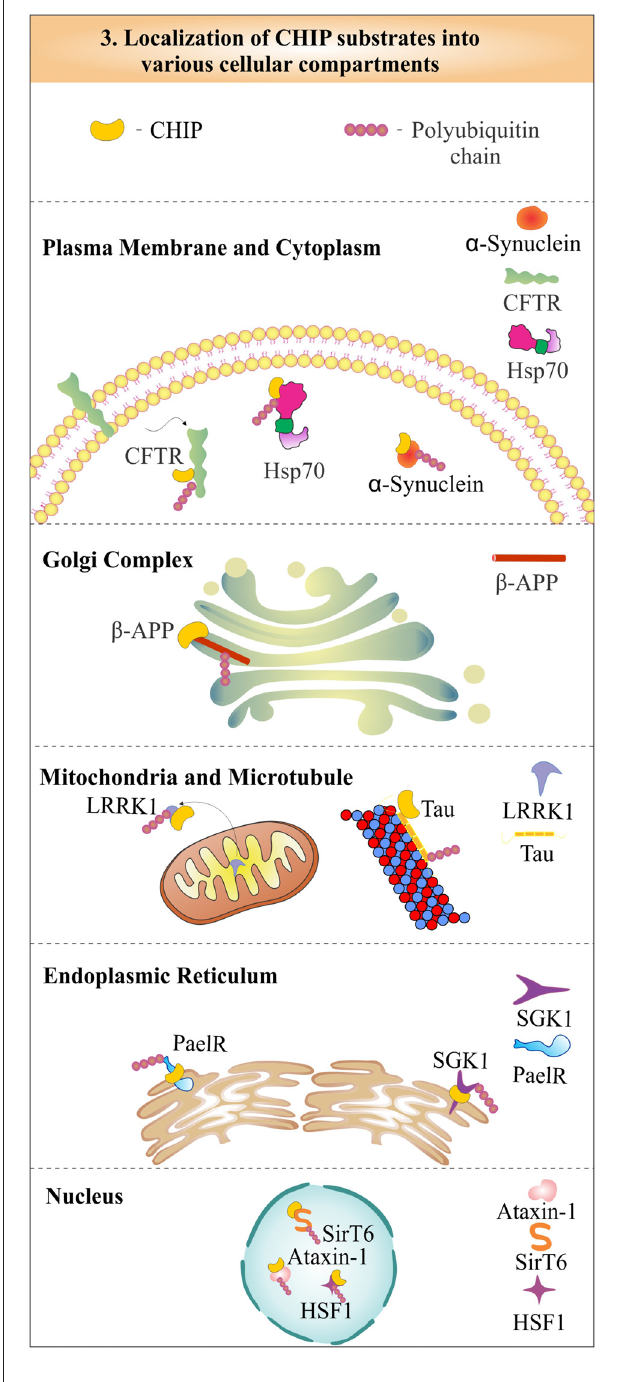
FIGURE 3 | Represenation of subcellular localization of CHIP in various cellular compartments. CHIP is widely distributed in most of the subcellular compartments, including nucleus, cytoplasm, endoplasmic reticulum and plasma membrane, in association with its